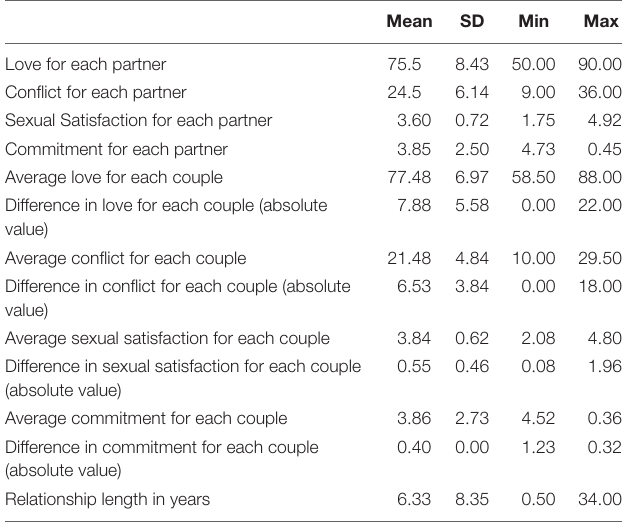
TABLE 1 | Summary of relationship variables for 68 partners in 34